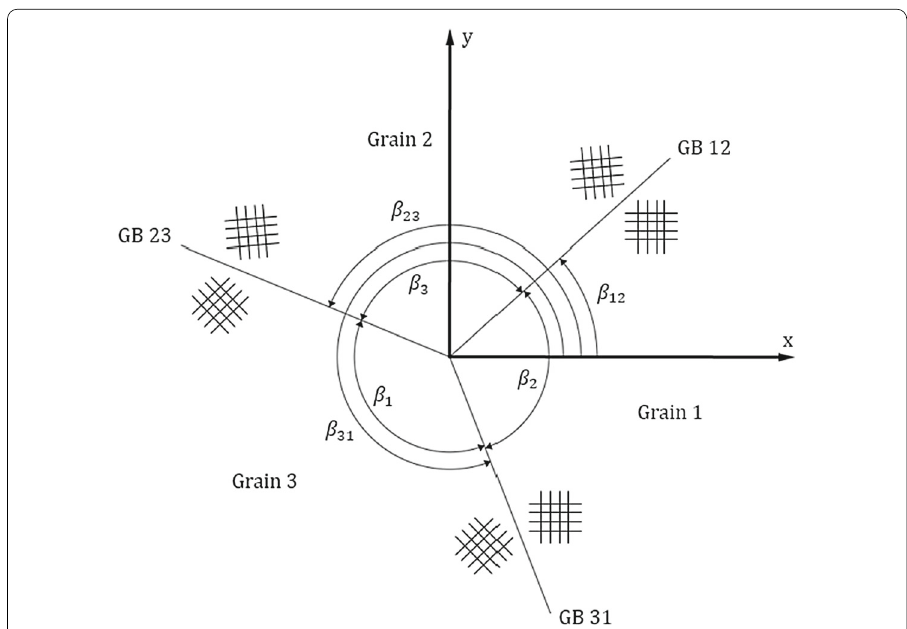
Fig. 1 Schematic showing the geometric configuration of a triple junction as described by Eqs. (13)–(15)